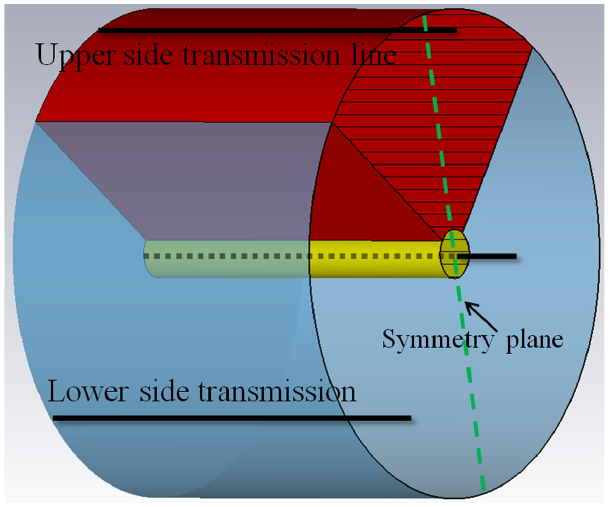
FIG. 1. Virtual division of an Alvarez-type cavity into three sections to be modeled by one transmission line each.